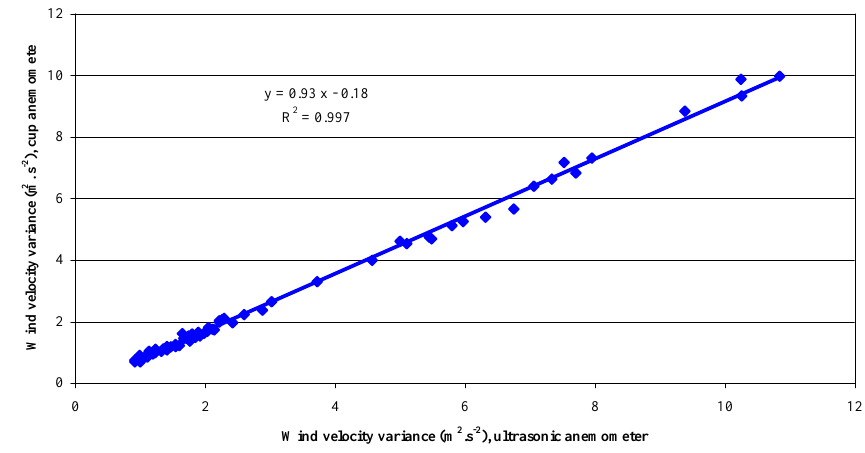
Figure 8 Fig. 8. Comparison of the wind speed variances measured by the ultrasonic and a cup anemometer (NKE 25-2). Sampling frequency of 2Hz, with spectral linear compensation. Table 5. Comparison between the wind speed variances from the ultrasonic and the cup anemometer (NKE 25-2). Parameters of linear regression and data relating to the relative underestimation from the cup anemometer. Sampling rates 1Hz without 2Hz without 2Hz